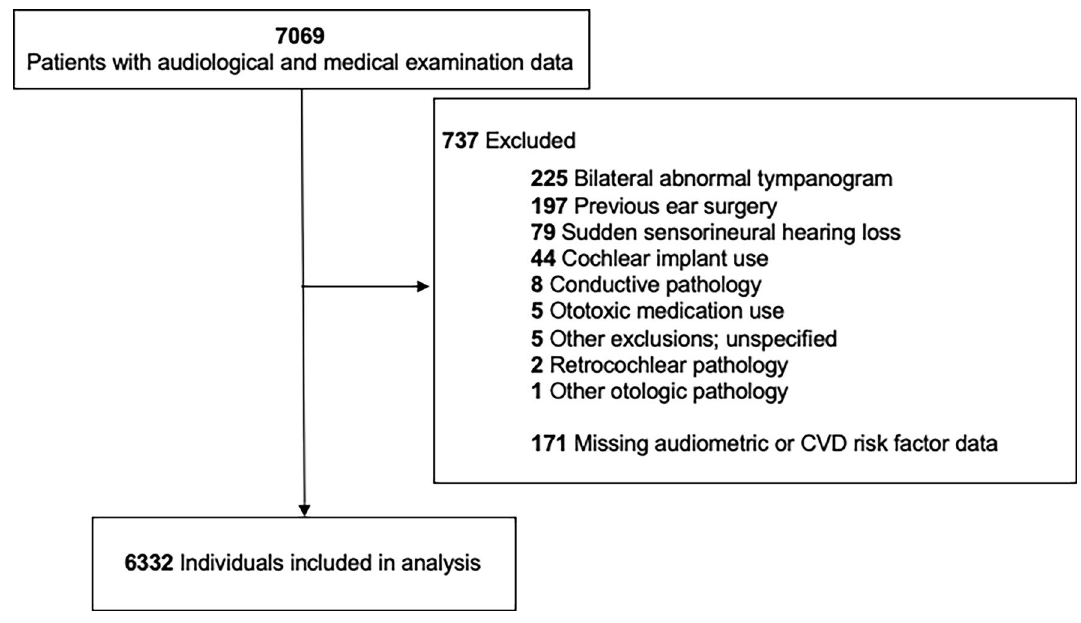
Figure 1. Flowchart of patient